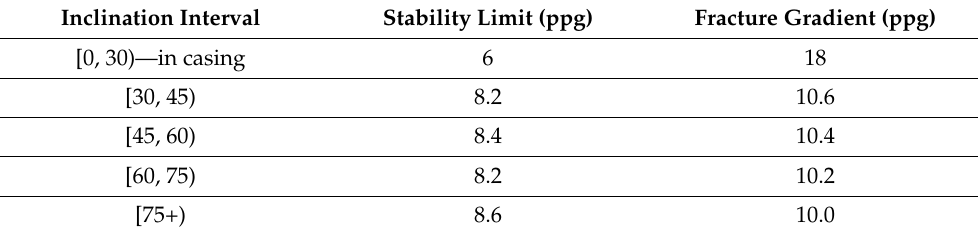
Table 3. The SL and FG values to define drilling margin for the different inclination intervals.